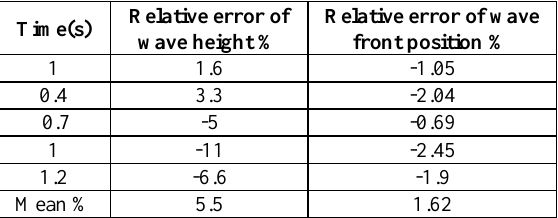
TABLE 3 Evaluation of the ISPH numerical model via relative error statistic of the position of the wave front for the solitary wave test